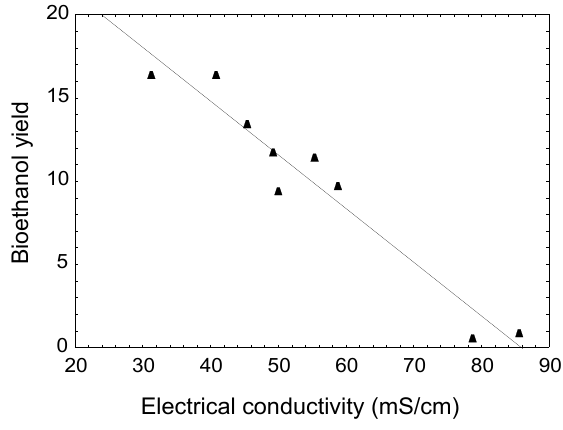
Figure 6. Relation between bioethanol yield (%, g EtOH/g conductivity of the hydrolysates ( R 2 =